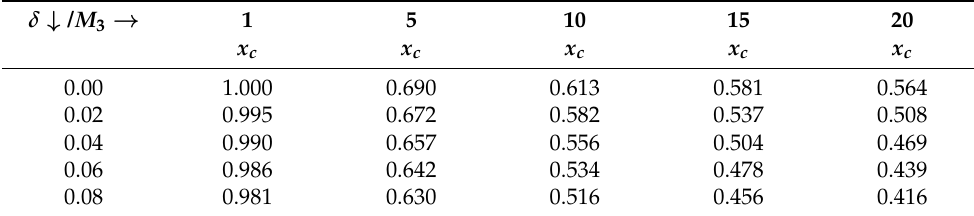
Table 4. x c for the case of stationary convection for different values of δ and M 3 .